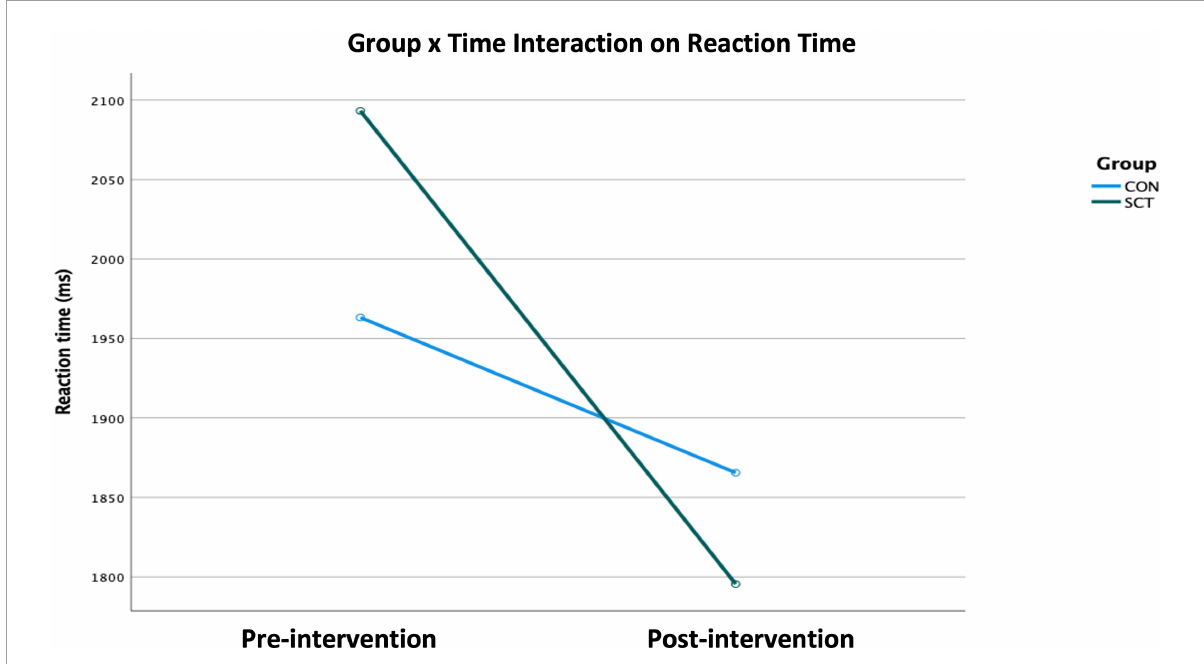
FIGURE2 Effect of the Group × Time interaction on reaction time as generated × the ANCOVA examining the variables Group, Time, and Emotion while adjusting for Gender, Age, IQ, and Years of education ( p <